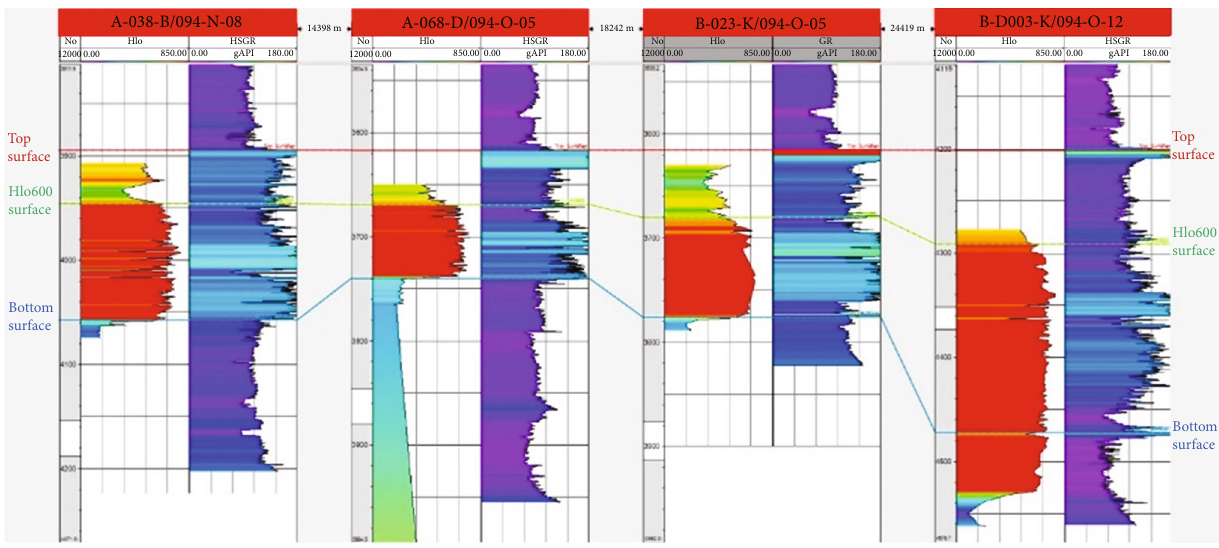
Figure 3: Stratigraphic correlation fi gures using original hydrogen index and gamma-ray